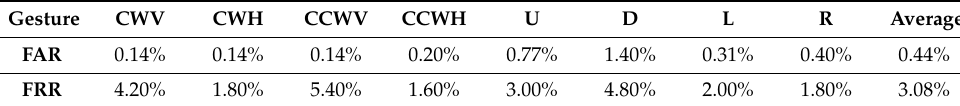
Table 10. FAR and FRR of each gesture in the user-independent